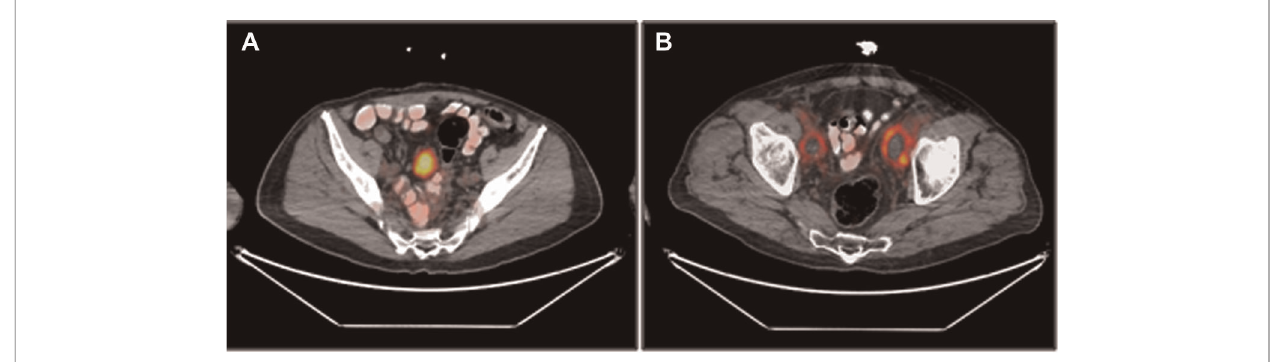
FIGURE 4 | Soft tissue uptake of [ 18 F]PSMA-1007, 1 h after injection. ( A ) uptake in a pelvic mass, subsequently identi fi ed as a desmoid tumor (patient #9). ( B ) Uptake in bilateral pelvic lymphoceles